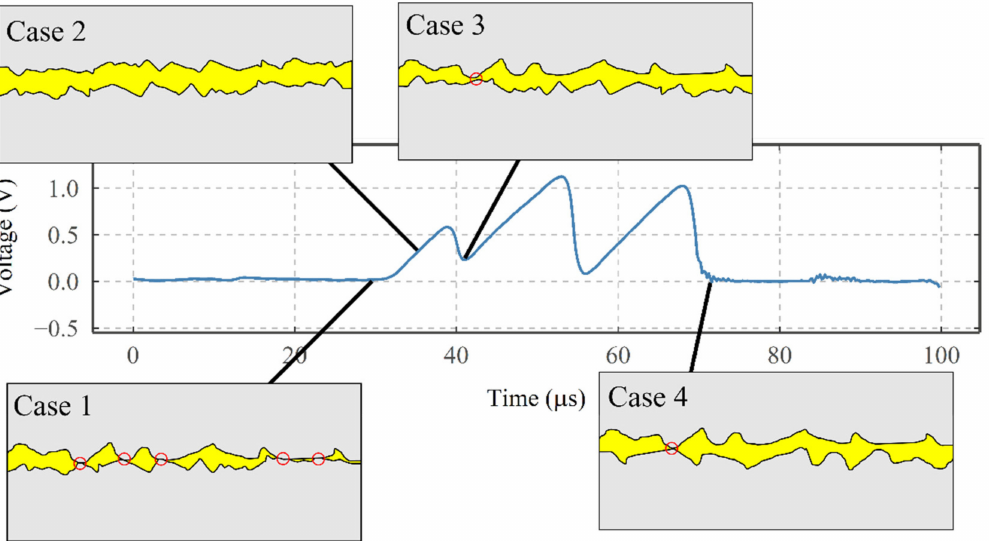
Figure 15. The charging and discharging periods together with the schematics, showing the influence of contact on the presence of these discharge